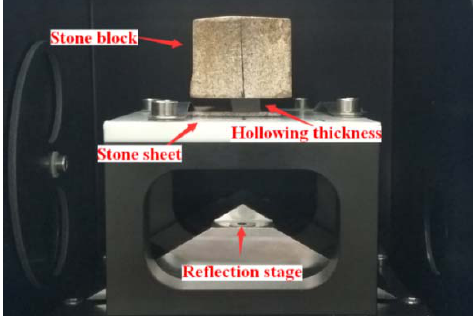
Figure 4. Schematic of the hollowing deterioration sample.